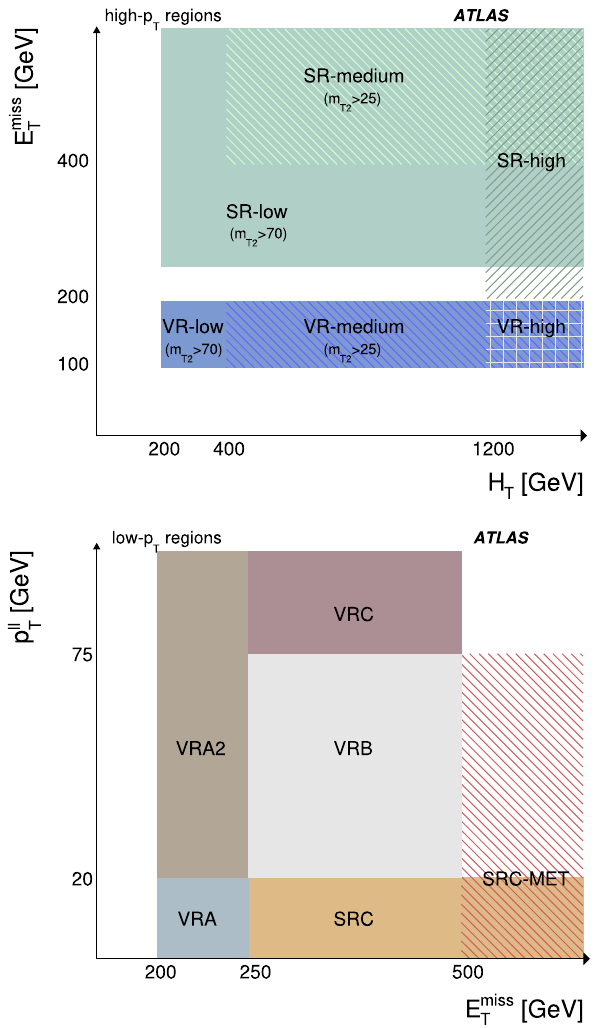
Fig. 2 Schematic diagrams of the main validation and signal regions for the high- p T (top) and low- p T (bottom) searches. Regions where hatched markings overlap indicate the overlap between various regions. For each search (high- p T or low- p T ), the SRs are not orthogonal; in the case of high- p T , the VRs also overlap. In both cases, as indicated in the diagrams, there is no overlap between SRs and VRs ϒ resonances. To isolate signal models with small (cid:7) m χ ,